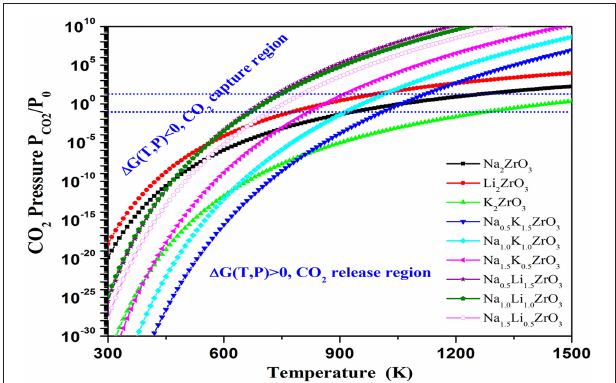
FIGURE 6 | The contour plotting of calculated Gibbs free energy vs. CO 2 pressures and temperatures of the CO 2 capture reactions by Na x M 2-x ZrO 3 and M 2 ZrO 3 (M = Li, Na, K, x = 0, 0.5, 1.0, 1.5, 2.0) through reaction Na x M 2 − x ZrO 3 + CO 2 = x / 2 Na 2 CO 3 + 2 − x / 2 M 2 CO 3 + ZrO 2 . Y-axis plotted in logarithm scale. The line shows 1 G(T, P) = 0. For each reaction, above its 1 G(T, P) = 0 curve, its 1 G < 0, which means the solids absorb CO 2 and the reaction goes forward, whereas below the 1 G(T, P) = 0 curve, its 1 G > 0, which means the CO 2 starts to release and the reaction goes backward to regenerate the sorbents.